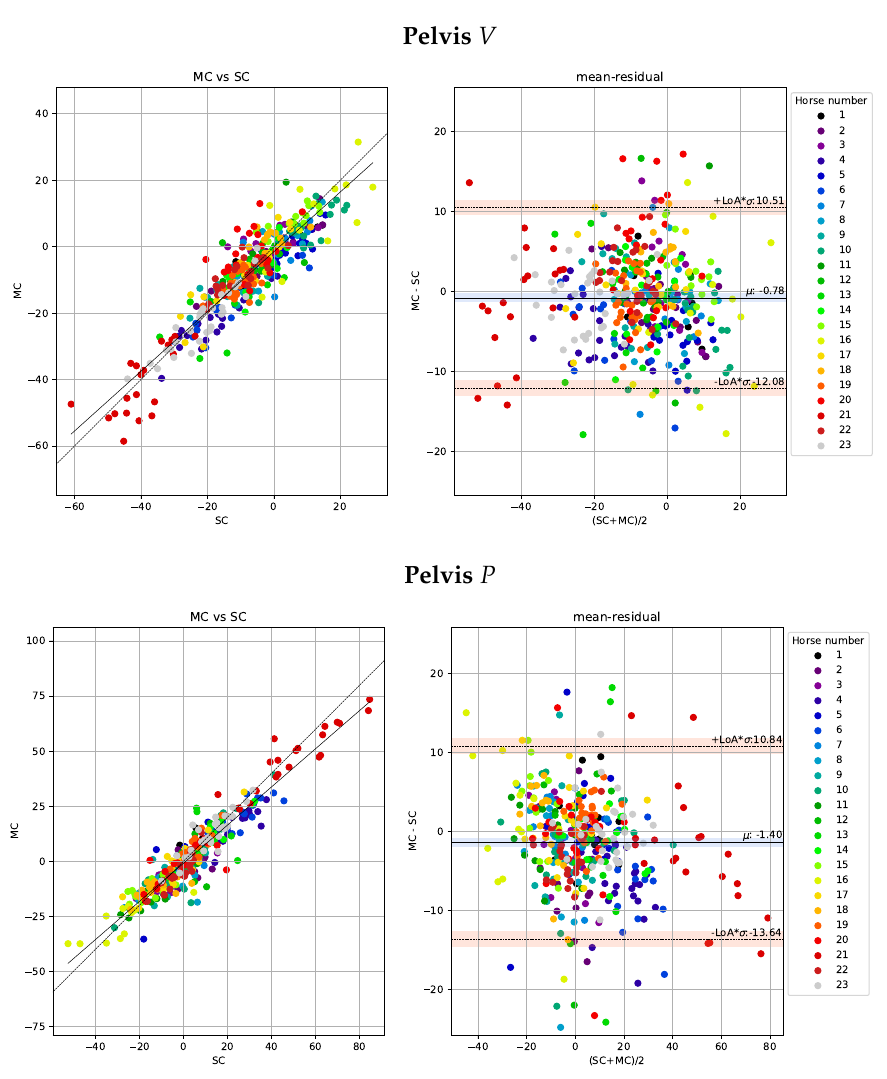
Figure 6. Scatter plots of the pelvic metrics obtained per stride (n = 404) observed by the multi-camera marker-based motion capture system (MC) plotted against the observation by the single-camera markerless system (SC) are shown in the left sub-panels. Agreements between the systems with limits of agreement (LoA) displayed as orange horizontal lines are presented in the Bland-Altman plots (right sub-panels). In the top row, we show the ∆ V (MinDiff) and the bottom row we show ∆ P (MaxDiff) defined in Section